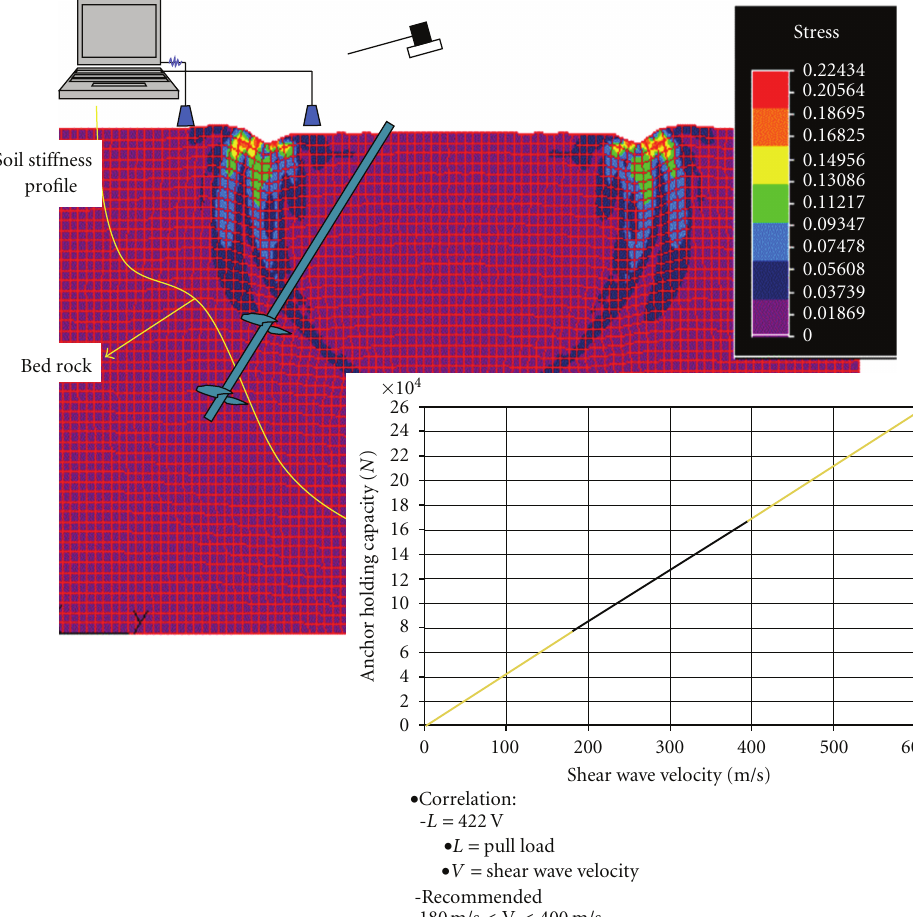
Figure 9: Elastic design of anchors based on surface wave soil testing.